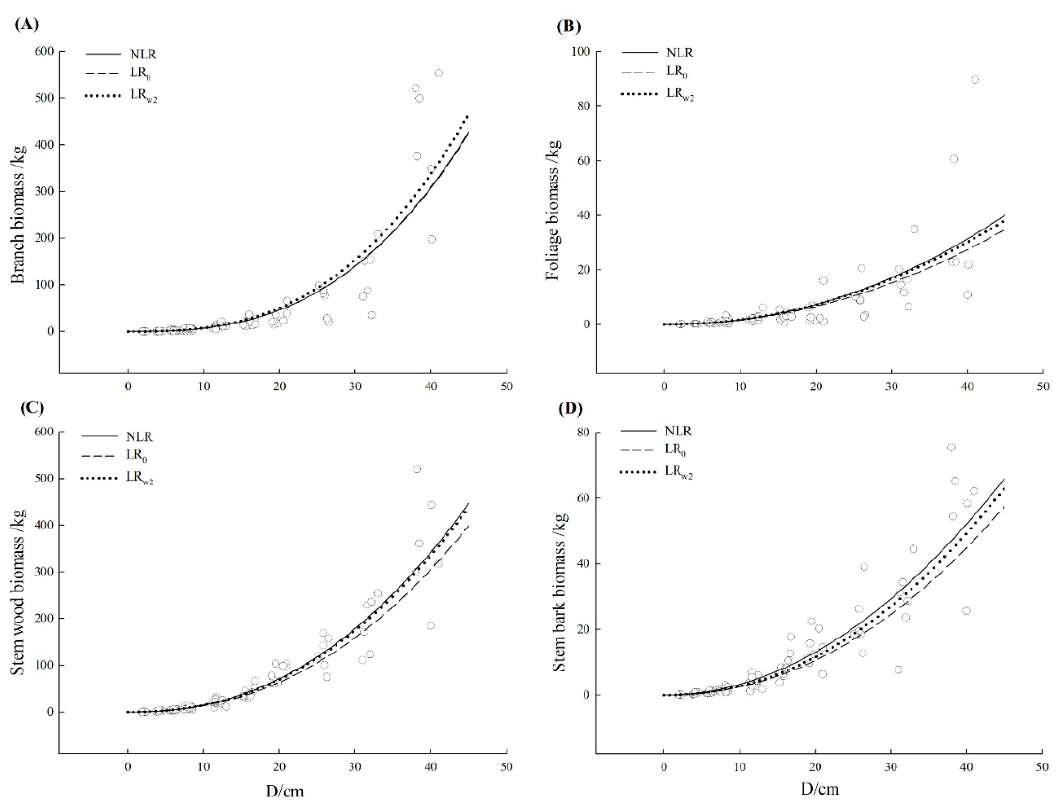
Figure 2. The curve fitted from nonlinear regression (NLR), uncorrected linear regression (LR 0 ) and corrected linear regression based on the weighted average of secondly basic correction factor from each component equation that is CF w2 ((LR w2 ) for Cinnamomum camphora ( Cinnamomum camphora (L.) Presl). The scattered points were the observations from data. ( A )–( D ) represented branch, foliage, stem wood, and stem bark, respectively. The solid line represented the nonlinear regression model (NLR), the dashed line represented the uncorrected linear regression model (LR 0 ) and the dotted line represented the corrected linear regression based on the weighted average of secondly basic correction factor from each component equation that is CF w2 (LR w2 ).